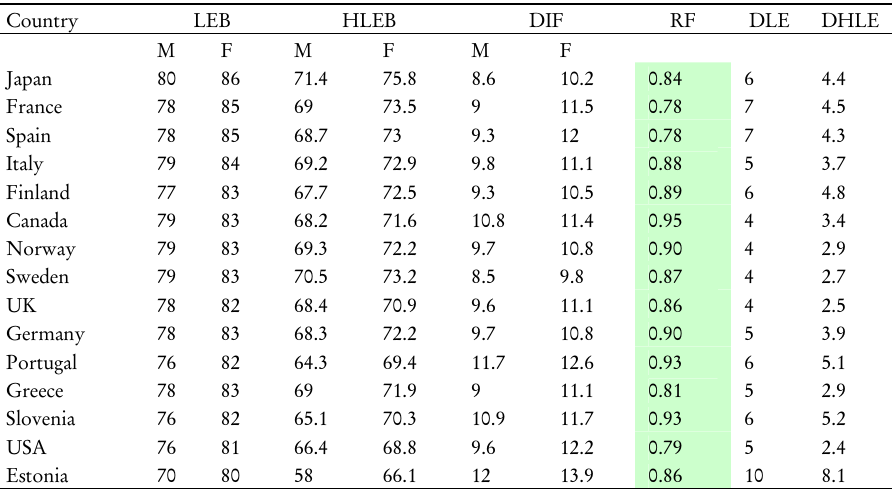
Legend LEB: Life Expectancy at birth for all 15 countries, disaggregated by sex (F,M). HLEB: Healthy Life Expectancy at birth for all 15 countries, disaggregated by sex (F,M). DIF: difference between LEB and HLEB by sex RF: ratio M/F for difference DIF DLE: difference between female and male in Life Expectancy at birth (LEB). DHLE: difference bewteen female and male in Healthy Life Expectancy at birth